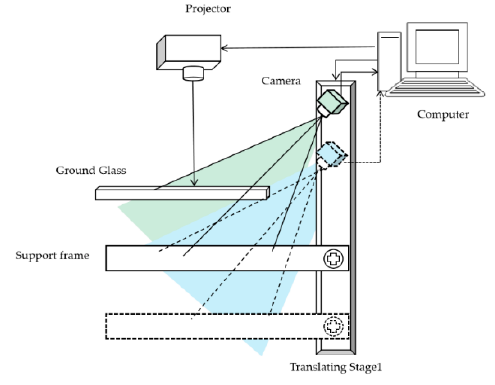
Figure 1. Measurement principle of the proposed infrared phase-measuring deflectometry (IR-PMD)